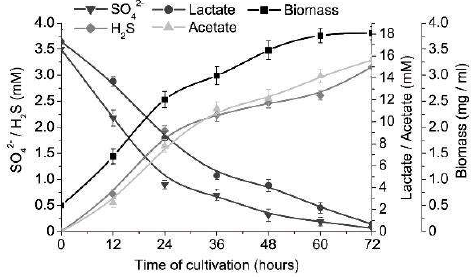
Figure 1. The growth of D. piger Vib-7 and their sulfate reduction.